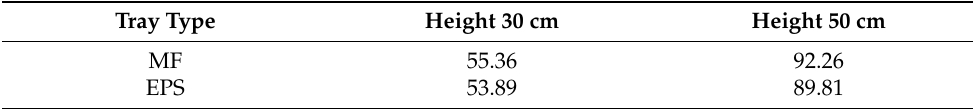
Table 1. Equivalent impact energy (J) of the package